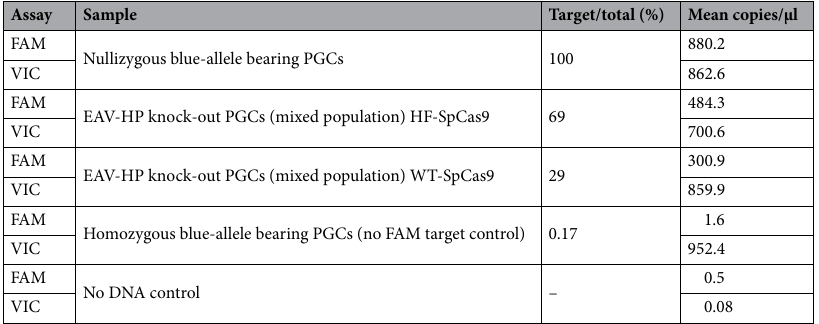
Table 1. Results of digital PCR 1 of nullizygous and knock-out